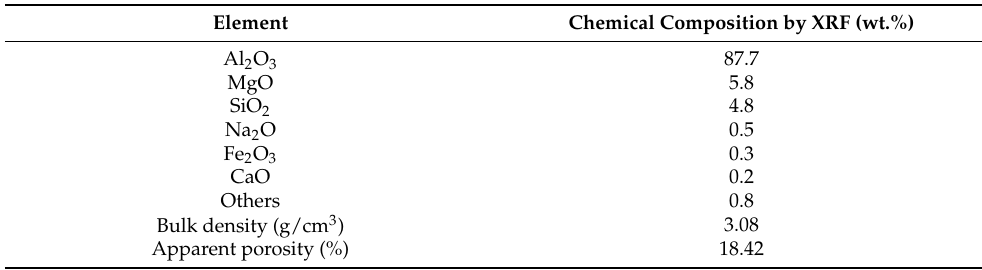
Table 2. Characteristics of alumina-spinel.